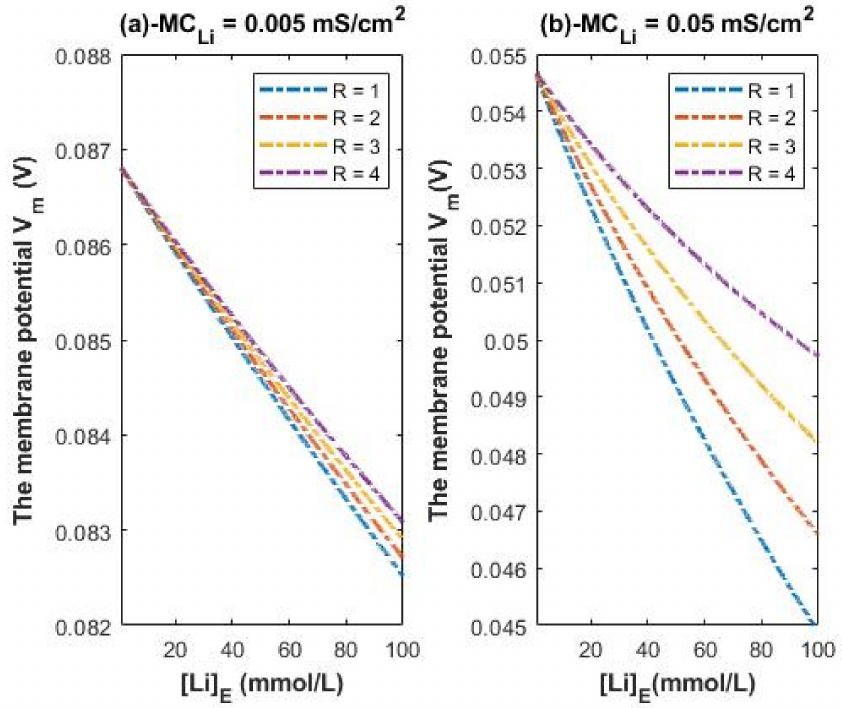
Figure 8. The figure represents the influence of classical transport of lithium ions on the resting membrane potential according to the concentration range 1–100 mmol/L. ( a ) The influence on resting membrane potential is evaluated when the membrane conductance of lithium is 0.005 mS/cm 2 (the same as the conductance for sodium ions). ( b ) The influence on resting membrane potential is evaluated when the membrane conductance of lithium is 0.05 mS/cm 2 . This is applied on both lithium isotopes, assuming that the conductance ratio Li-6/Li-7 =1.006, which does not affect the mathematical graphs in this